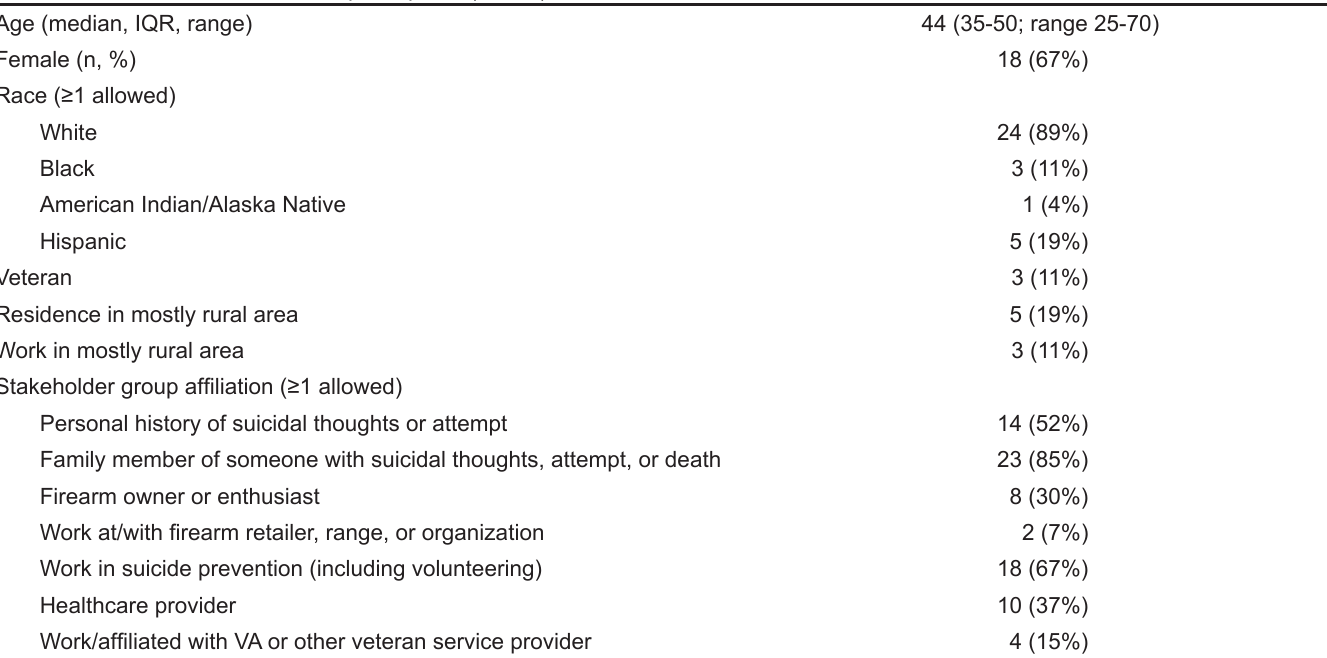
Table 1. Characteristics of interview participants (n = 27).